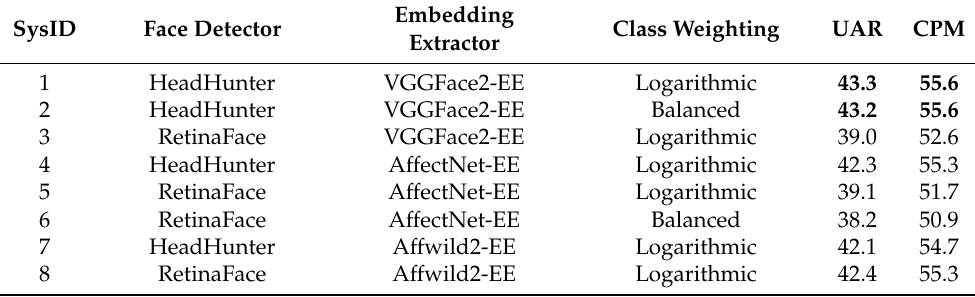
Table 3. The performance results (%) for different combinations of face detectors, embeddings extractors, and class weighting schemes. SVM was used as a classifier on the suprasegmental features. The best results within the column are highlighted in bold.